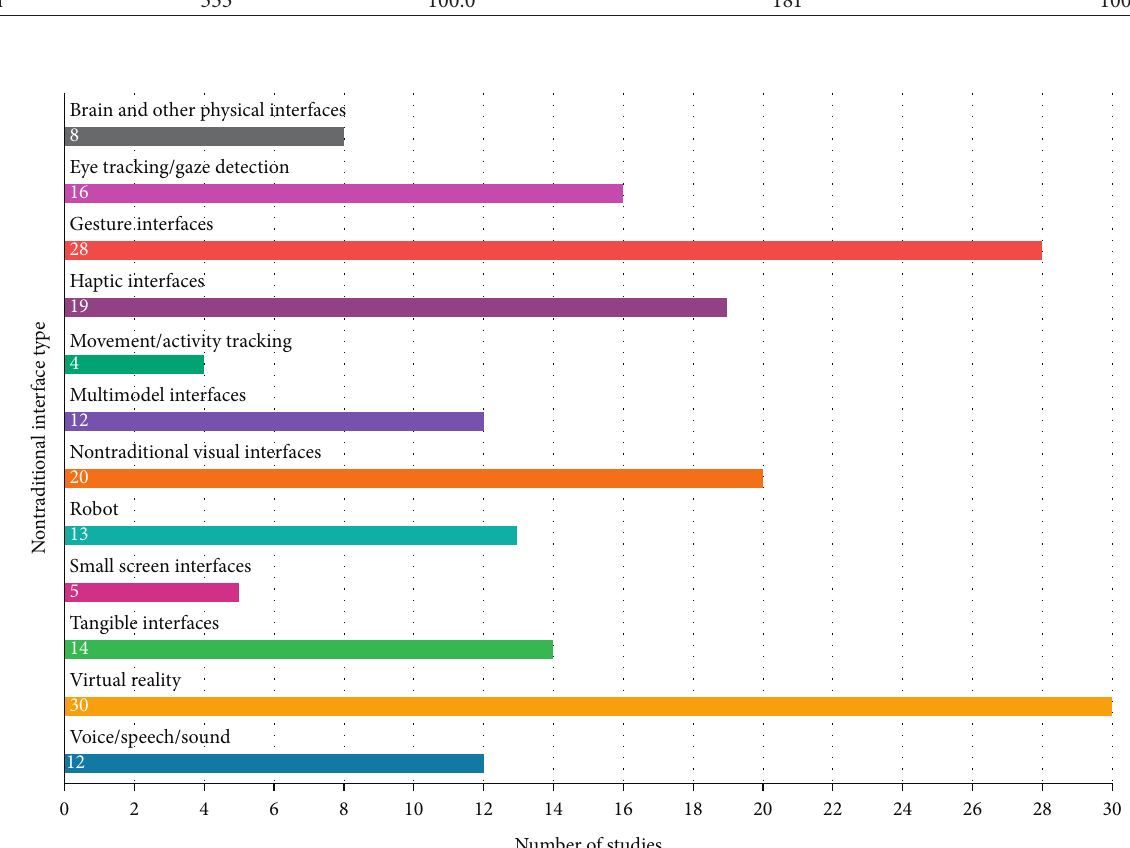
Figure 13: Number of studies with nontraditional interfaces by interface